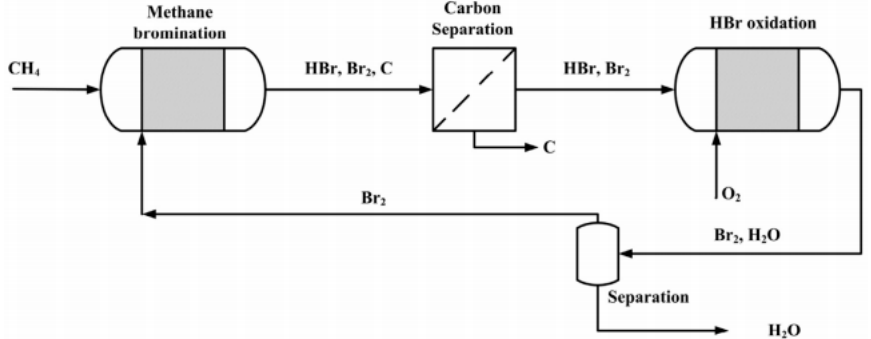
Figure 8. Schematic representation of methane oxidation in bromine mediated processes for energy and coke production. Reprinted from [94]. Processes 2020 , 8 , x FOR PEER REVIEW